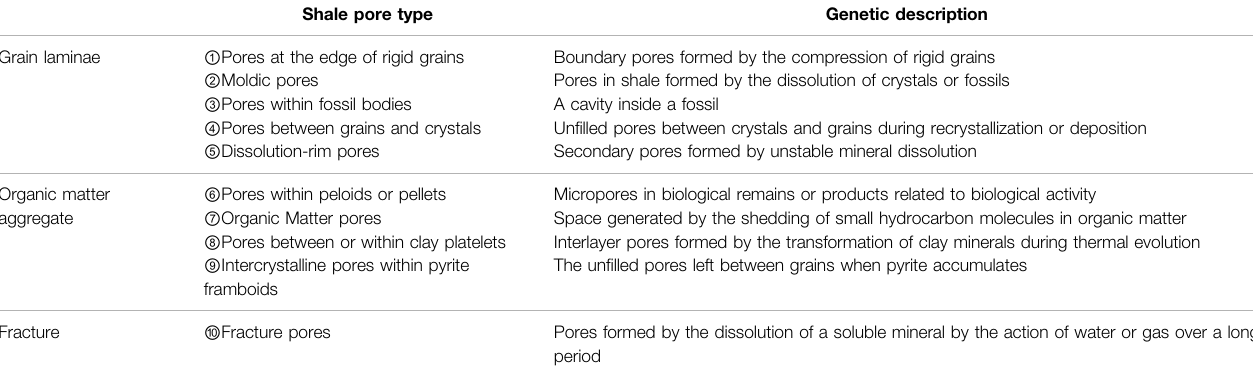
TABLE 3 | The type of shale pores and their genetic description. Shale pore type Genetic description Grain